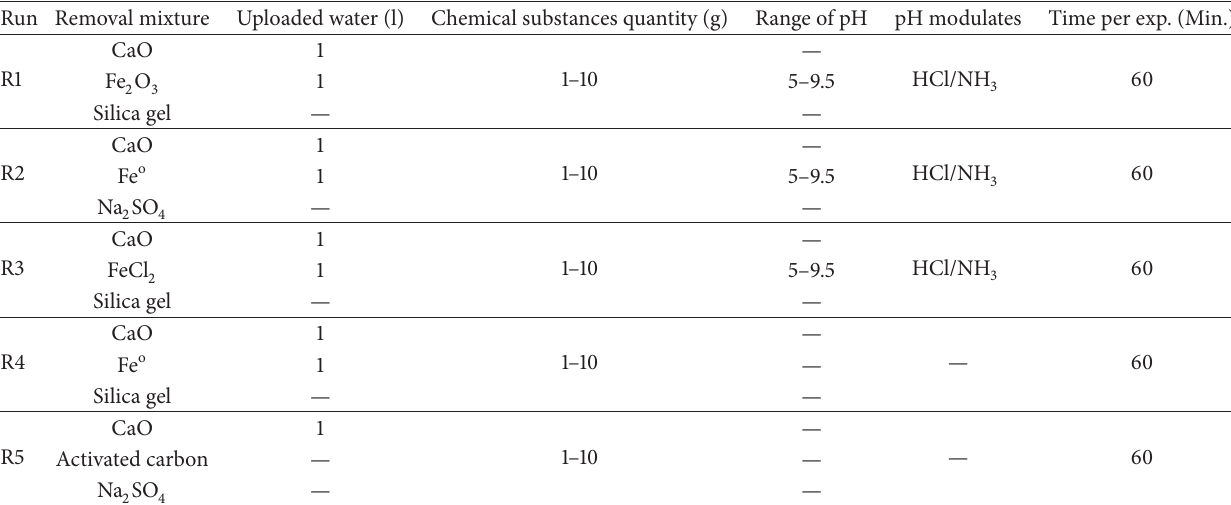
Figure 1: Schematic of experimental apparatus set-up for purification of biogas. Table 1: Experimental properties of methane enhancement research